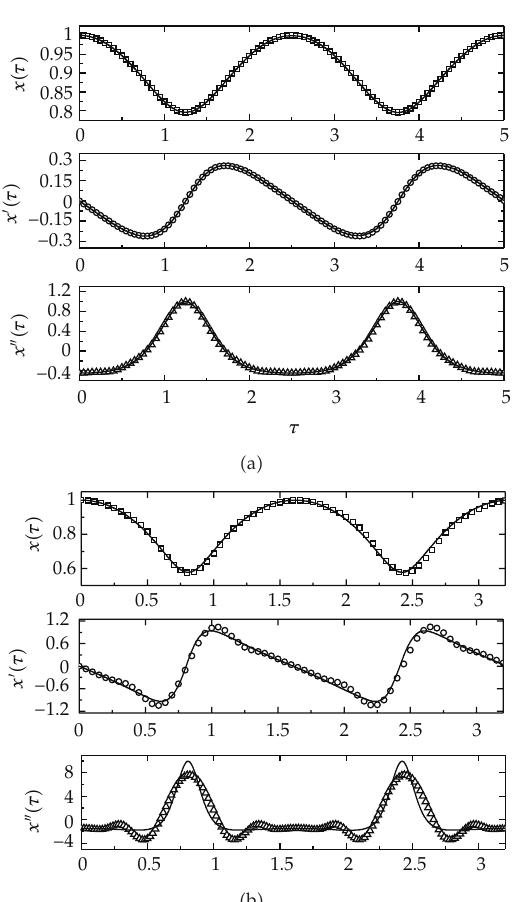
Figure 8: Comparison between 4th-order HAM solutions (cid:3) hollow symbols (cid:4) and Runge-Kutta numerical solutions (cid:3) solid lines (cid:4) for: x (cid:3) τ (cid:4) , x (cid:6) (cid:3) τ (cid:4) and x (cid:6)(cid:6) (cid:3) τ (cid:4) at di ff erent values of β . (cid:3) a (cid:4) α (cid:9) 1, β (cid:9) 0 . 443495 (cid:3) p (cid:9) 300Pa (cid:4) , θ (cid:9) 1, a (cid:9) 1 . 00002, h (cid:9) − 1 . 4; (cid:3) b (cid:4) α (cid:9) 1, β (cid:9) 1 . 47832 (cid:3) p (cid:9) 1000Pa (cid:4) , θ (cid:9) 1, a (cid:9) 1 . 00002, h (cid:9) − 1 . 7. All parameter values are for a MEB containing 10 4 electrons with an equilibrium radius R c (cid:9) 1 . 06441 μ